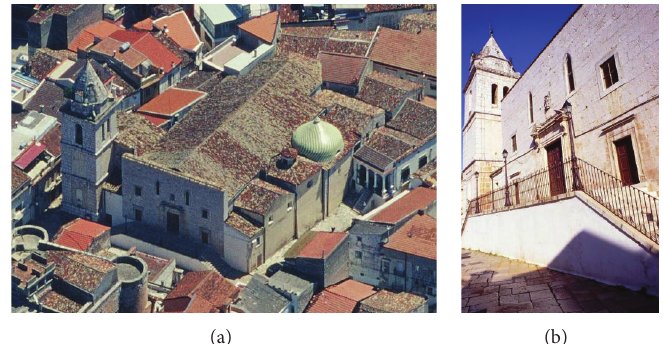
Figure 1: (a) Photograph of Madre Santa Maria del Borgo church, San Nicandro, Italy, and (b) fac¸ade of the church.